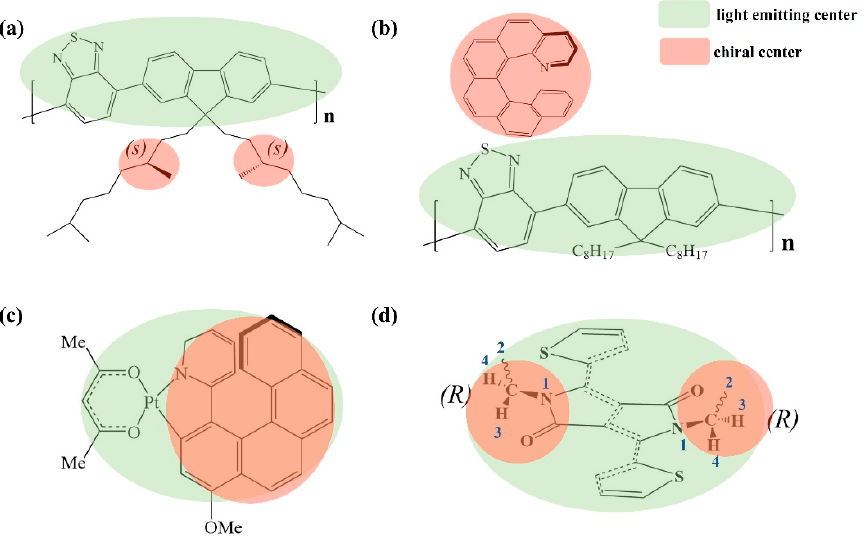
Figure 1. Typical CP light-emitting materials: ( a ) conjugated polymer with chiral side chains; ( b ) mixing an achiral light-emitting molecule with chiral molecules; ( c ) small molecule with light-emitting center overlaps with the chiral center; and ( d ) the proposed chiral materials by adding an achiral side chain to the achiral light-emitting core, then the chirality is introduced.